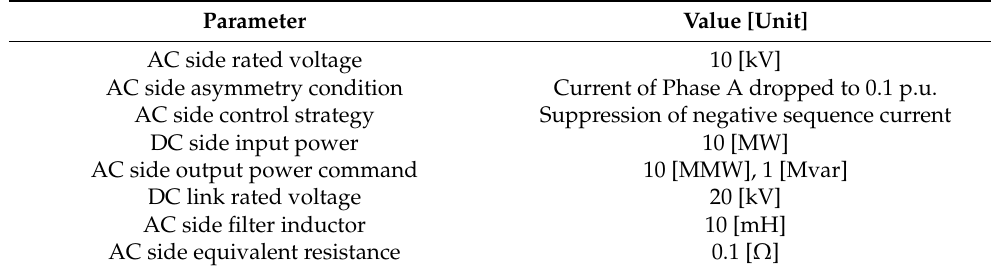
Table 1. Bechmark